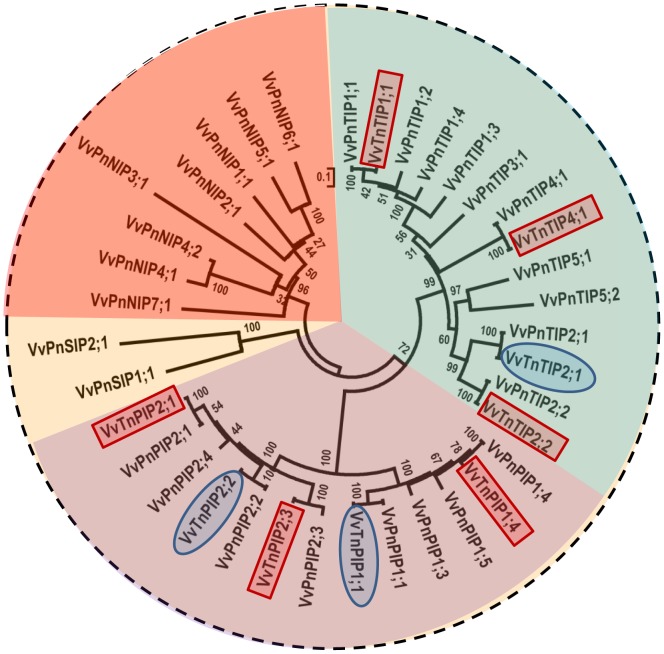
Phylogenetic tree based on protein sequences of aquaporins from V. vinifera cv. Pinot noir and cv. Touriga nacional.Dendrogram depicting the phylogenetic relationship between the aquaporins of Touriga nacional variety cloned in this study (framed in rectangular shape), previous study (oval shape frame) [17] with the aquaporins of Pinot noir variety. Dendogram was generated by neighbor-joining method (applied to 1000 bootstrap data sets) using the MEGA5.1 program [26]. Accession numbers of presented protein sequences are: VvPnPIP1;1 (CAO41326, GSVIVT00029248001), VvPnPIP1;3 (CAO62835, GSVIVT00000433001), VvPnPIP1;4 (CAO39626, GSVIVT00026881001), VvPnPIP1;5 (CAO39627, GSVIVT00026882001), VvPnPIP2;1 (CAN75442), VvPnPIP2;2 (CAO47394, GSVIVT00036133001), VvPnPIP2;3 (CAO18152, GSVIVT00023192001), VvPnPIP2;4 (CAO21844, GSVIVT00024536001), VvPnTIP1;1 (CAO69259, GSVIVT00018548001), VvPnTIP1;2 (CAO63006, GSVIVT00000605001), VvPnTIP1;3 (CAO16745, GSVIVT00022146001), VvPnTIP1;4 (CAO21720, GSVIVT00024394001), VvPnTIP2;1 (CAO45860, GSVIVT00034350001), VvPnTIP2;2 (CAO23095, GSVIVT00012703001), VvPnTIP3;1 (CAO62035, GSVIVT00013854001), VvPnTIP4;1 (CAO44039, GSVIVT00032441001), VvPnTIP5;1 (CAO42713, GSVIVT00029946001), VvPnTIP5;2 (CAO70596, GSVIVT00019170001), VvPnNIP1;1 (CAO48005, GSVIVT00035815001), VvPnNIP2;1 (CAO15462, GSVIVT00011149001), VvPnNIP3;1 (CAO17108, GSVIVT00022377001), VvPnNIP4;1 (CAO70192, GSVIVT00007127001), VvPnNIP4;2 (CAO43338, GSVIVT00003903001), VvPnNIP5;1 (CAO62847, GSVIVT00000446001), VvPnNIP6;1 (CAO45476, GSVIVT00033750001), VvPnNIP7;1 (CAO71103, GSVIVT00019910001), VvPnSIP1;1 (CAO23510, GSVIVT00025504001) and VvPnSIP2;1 (CAO18284, GSVIVT00023346001) (for Pinot noir cultivar sequences) and VvTnPIP1;1 (HQ913643), VvTnPIP1;4 (KJ697714), VvTnPIP2;1 (KJ697715), VvTnPIP2;2 (HQ913642), VvTnPIP2;3 (KJ697716), VvTnTIP1;1 (KJ697717), VvTnTIP2;1 (HQ913640), VvTnTIP2;2 (KJ697718) and VvTnTIP4;1 (KJ697719) (for Touriga nacional cultivar sequences).